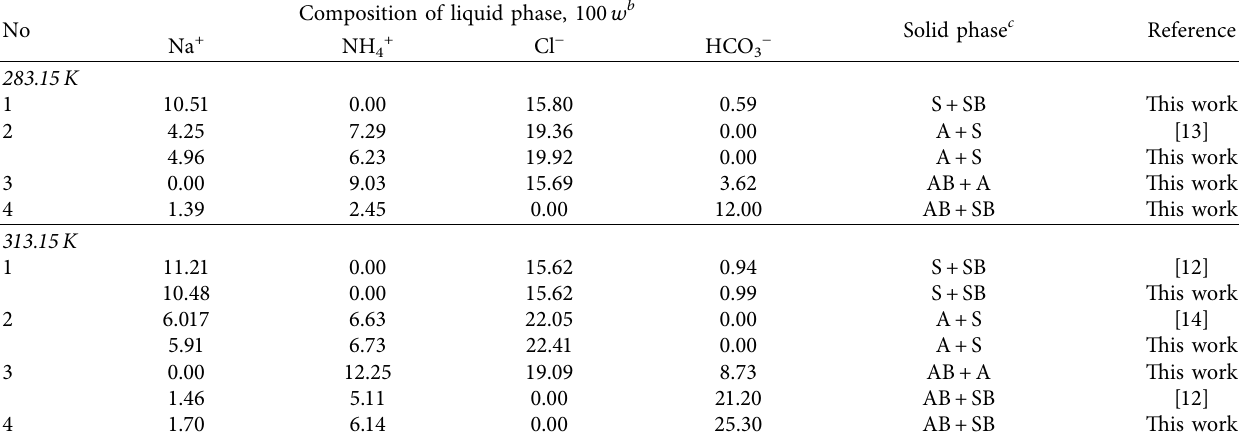
Table 2: Te comparison of solubility data of ternary systems at 283.15K, 313.15K, and 0.1MPa a .